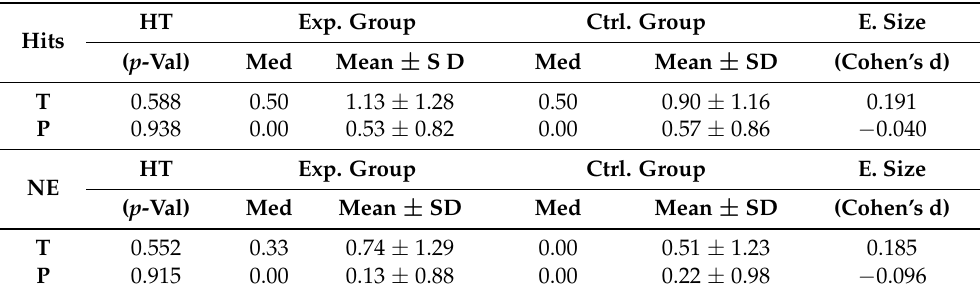
Table 1. Statistical analysis of the pre-test for the 10-item instrument. The first part of the table (Hits) uses the hits rating while the second one (NE) uses the null-expectation rating. HT: Hypothesis test; Med: Median; SD: Standard deviation; E. size: Effect size.